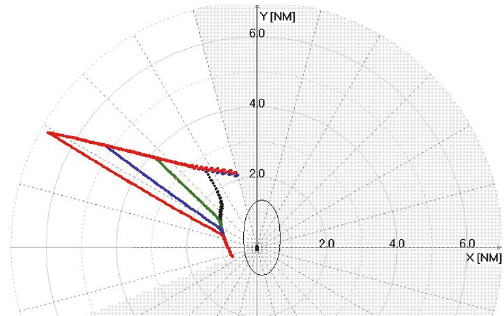
Figure 19: Action lines for stand-on crossing encounter with a target, whose true speed is 23 knots. Assumed are turns to starboard by 65 ∘ (red), 75 ∘ (blue), 90 ∘ (green), and 120 ∘ (black). No speed reduction.